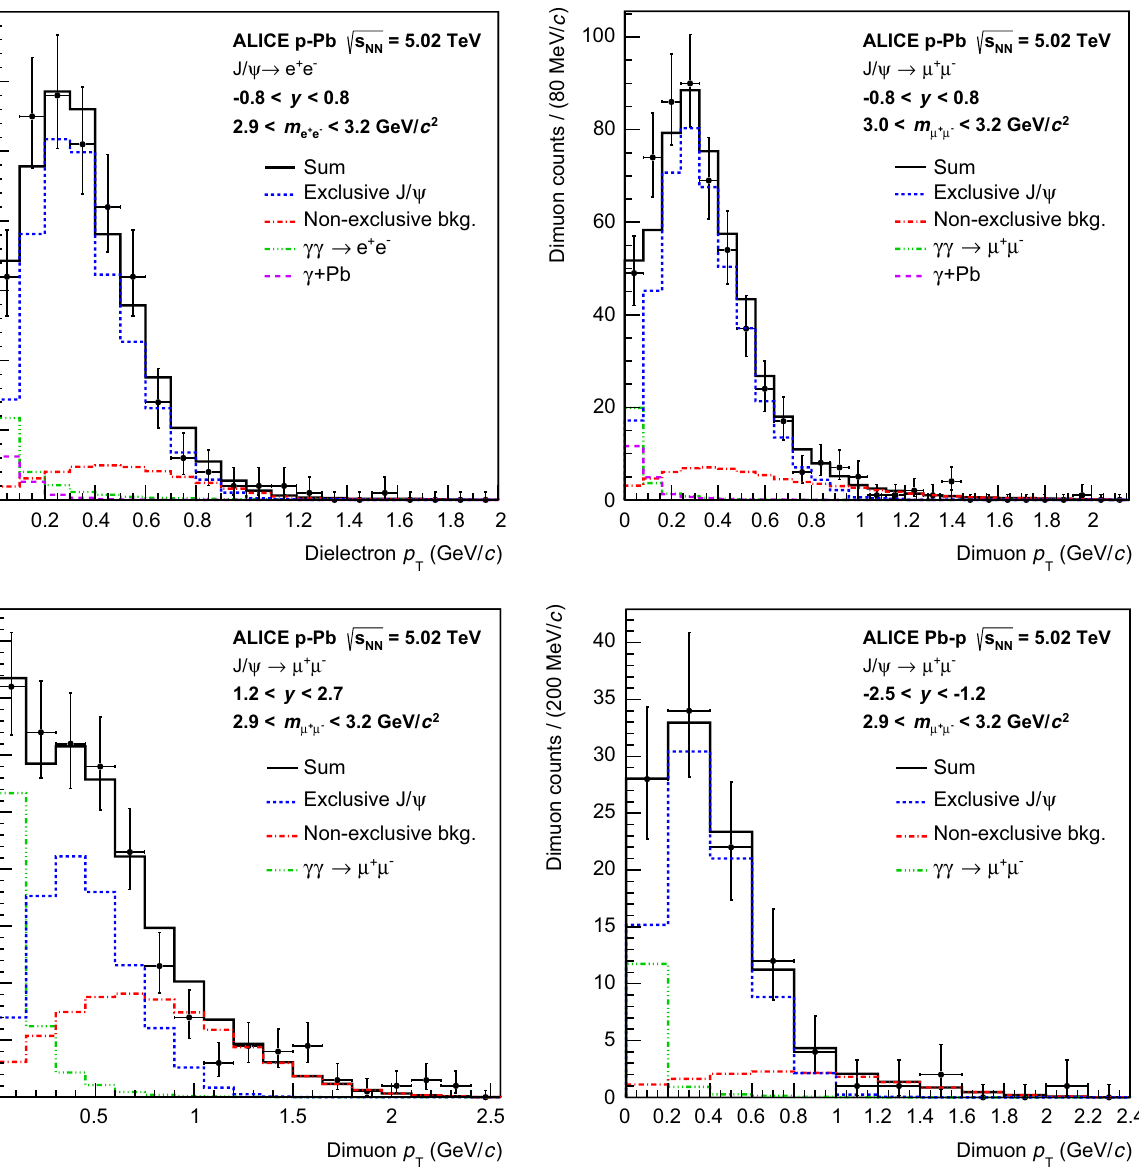
and green (dash-dot-dot) lines correspond to Monte Carlo templates for J /ψ coming from exclusive photoproduction off protons or off lead and continuous dileptonproduction respectively.Thered(dash-dot) lineisa template for dissociative and hadronic background obtained from